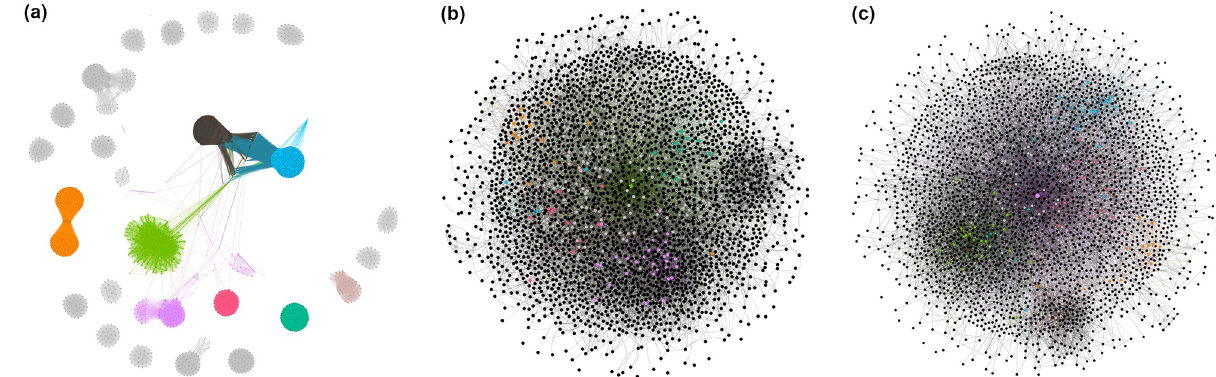
Fig 5. Projected user-user network visualizations for GitHub (degree � 25), Twitter, and Reddit (degree � 15). (a) GitHub (b) Twitter (c) Reddit.